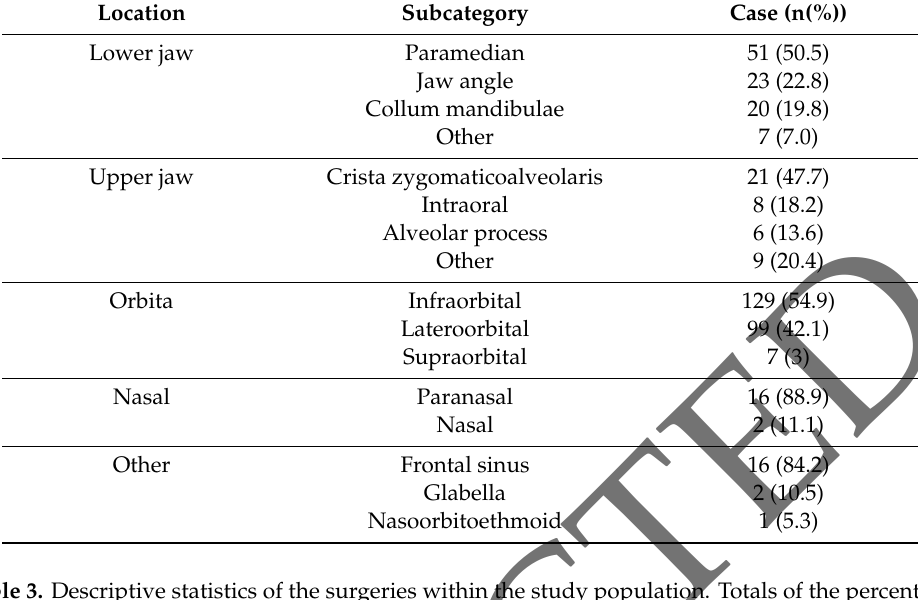
Table 3. Descriptive statistics of the surgeries within the study population. Totals of the percentages may not be exactly 100% because of